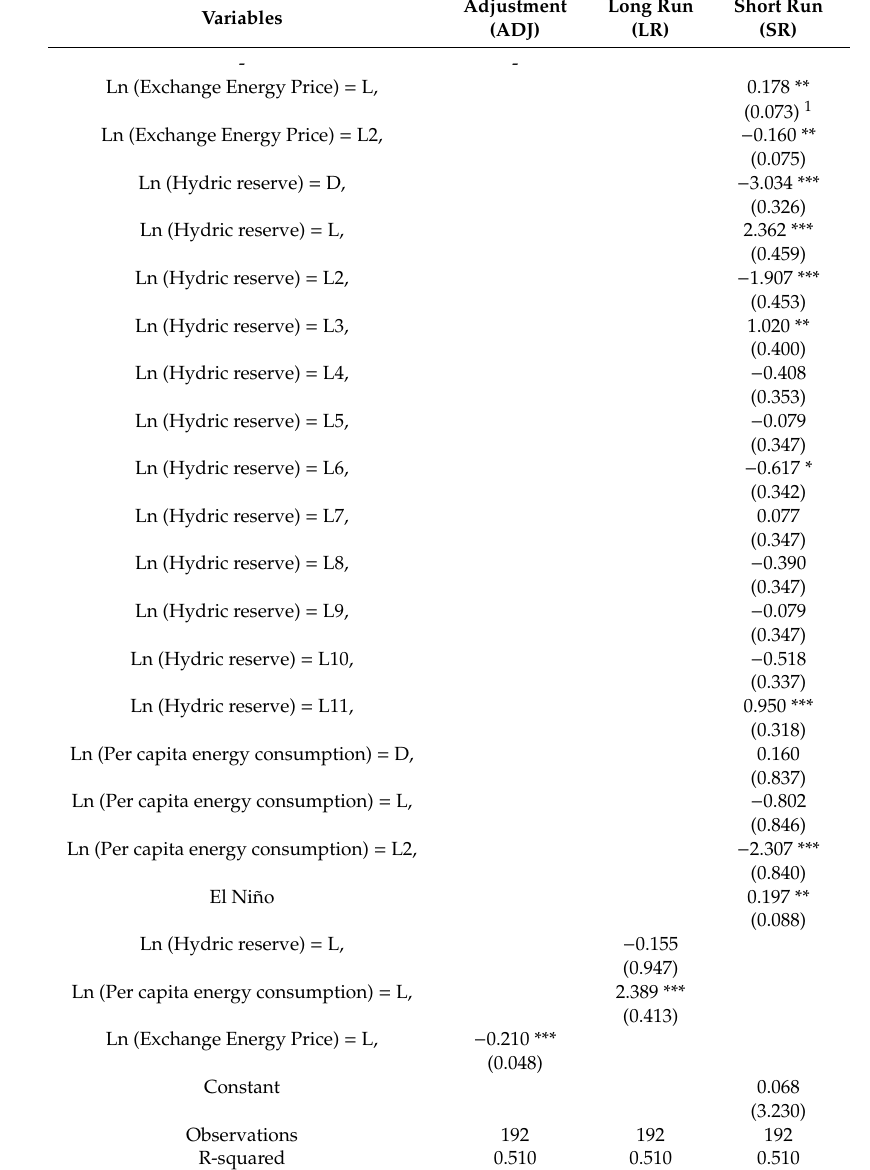
Table A5. Error correction